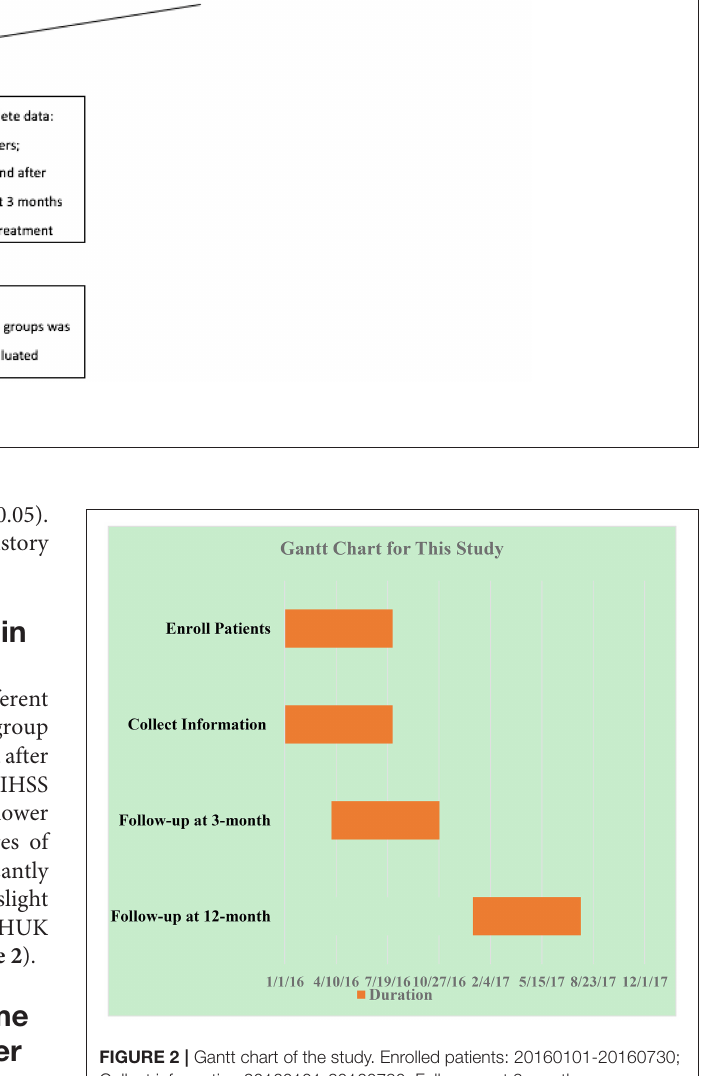
FIGURE 2 | Gantt chart of the study. Enrolled patients: 20160101-20160730; Collect information:20160101-20160730; Follow-up at 3 month: 20160401-20161030; Follow-up at 12 month: